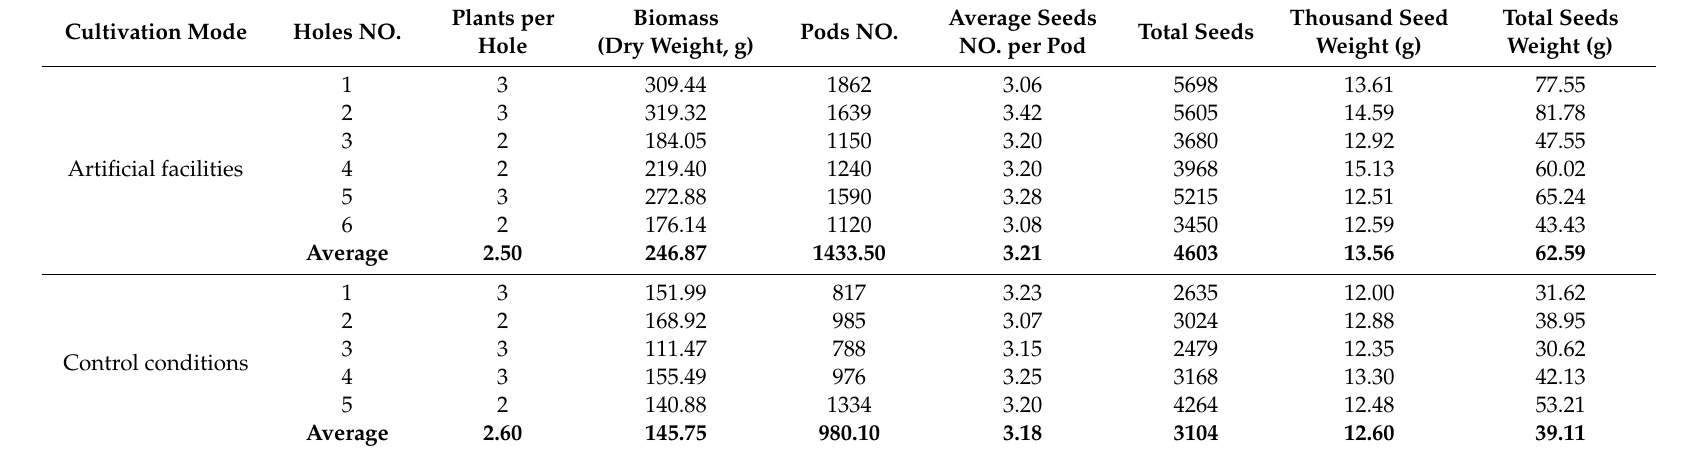
Table 1. Statistics of biomass and seeds yield of wild soybean with artificial facilities and control conditions. Cultivation